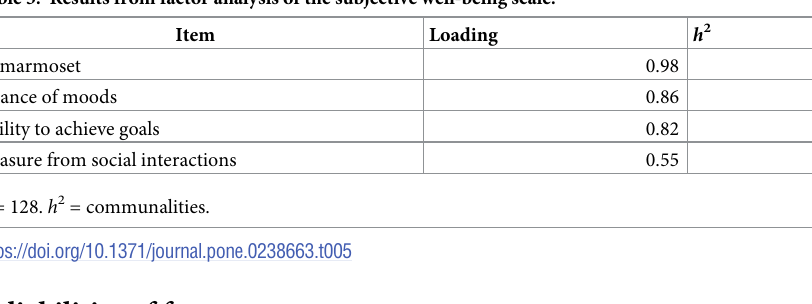
Table 5. Results from factor analysis of the subjective well-being scale.